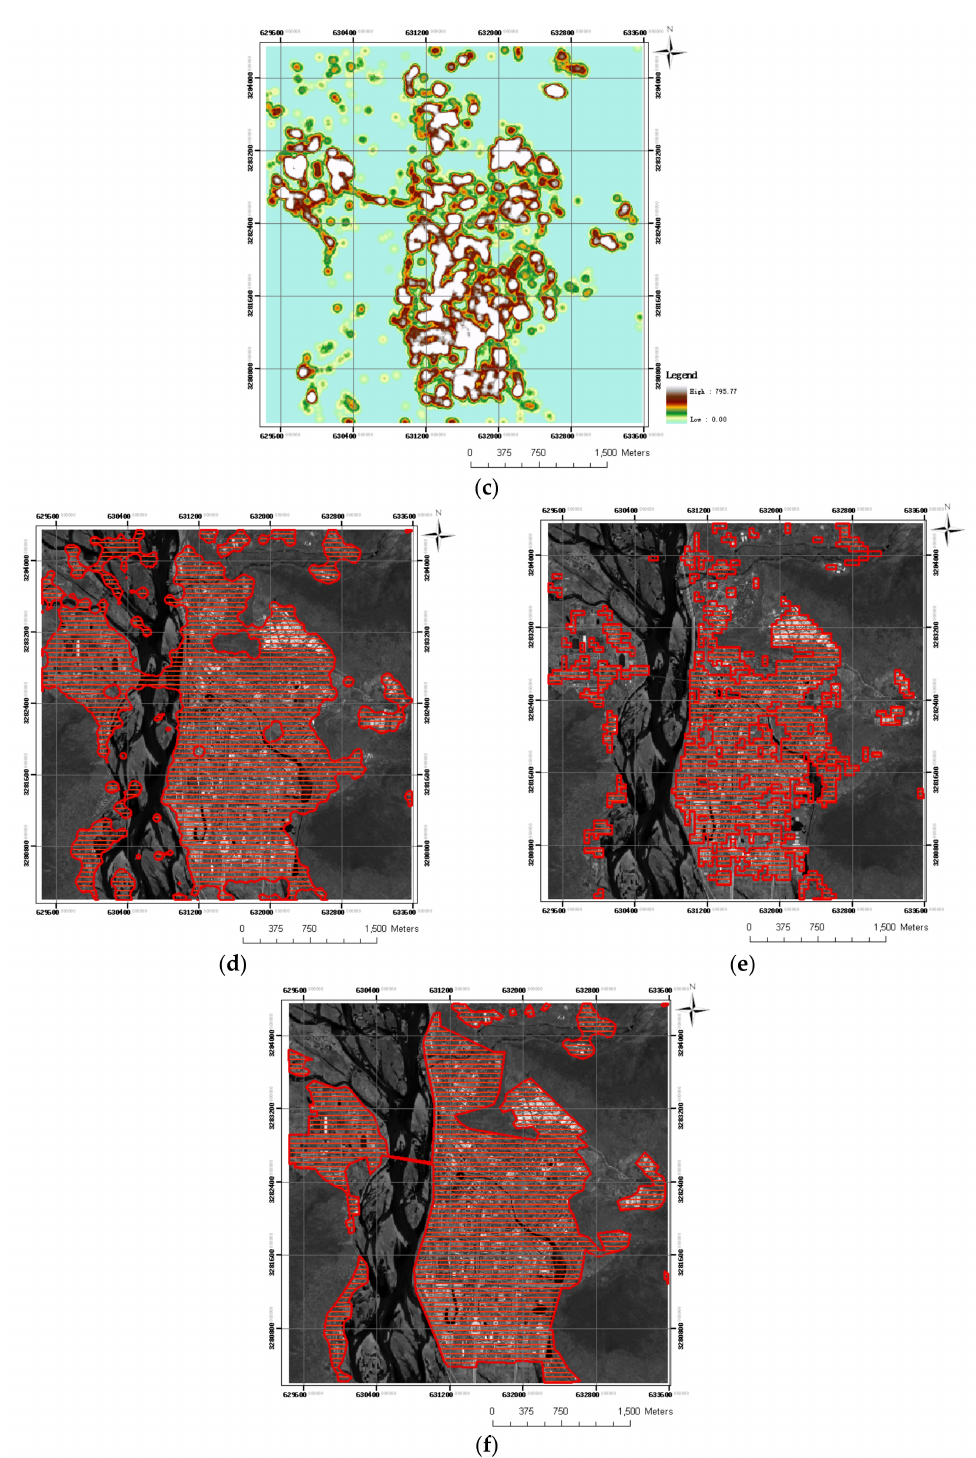
Figure 7. The third test image; the results of our method and the extracted built-up areas. ( a ) The VHSR satellite image; ( b ) the retained corners and line segments; ( c ) the constructed thematic image by spatial voting; ( d ) the final built-up area (by our proposed method) imposed on the original image; ( e ) the final built-up area by the PanTex method; ( f ) the reference built-up